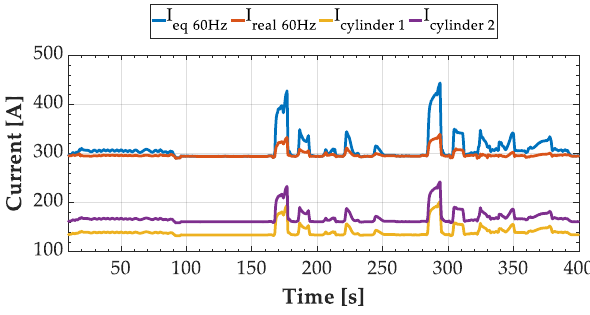
Figure 17. Peak of the equivalent current at 60 Hz (HDF factor) and internal distribution.